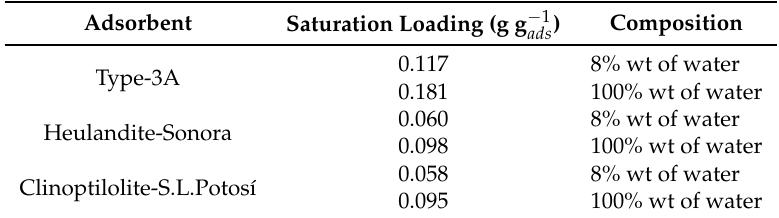
Table 5. Maximum saturations in two different concentrations with a constant temperature of 70 ◦ C.